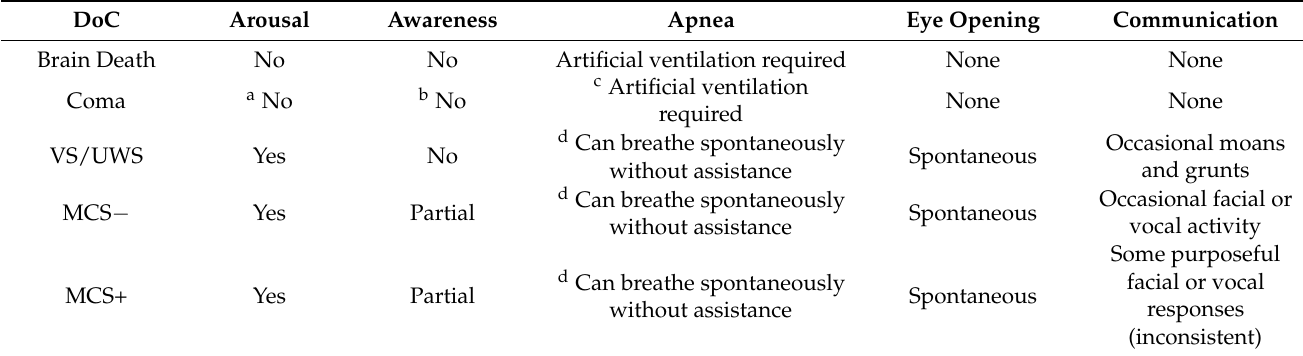
Table 1. Comparison of some clinical features in disorders of